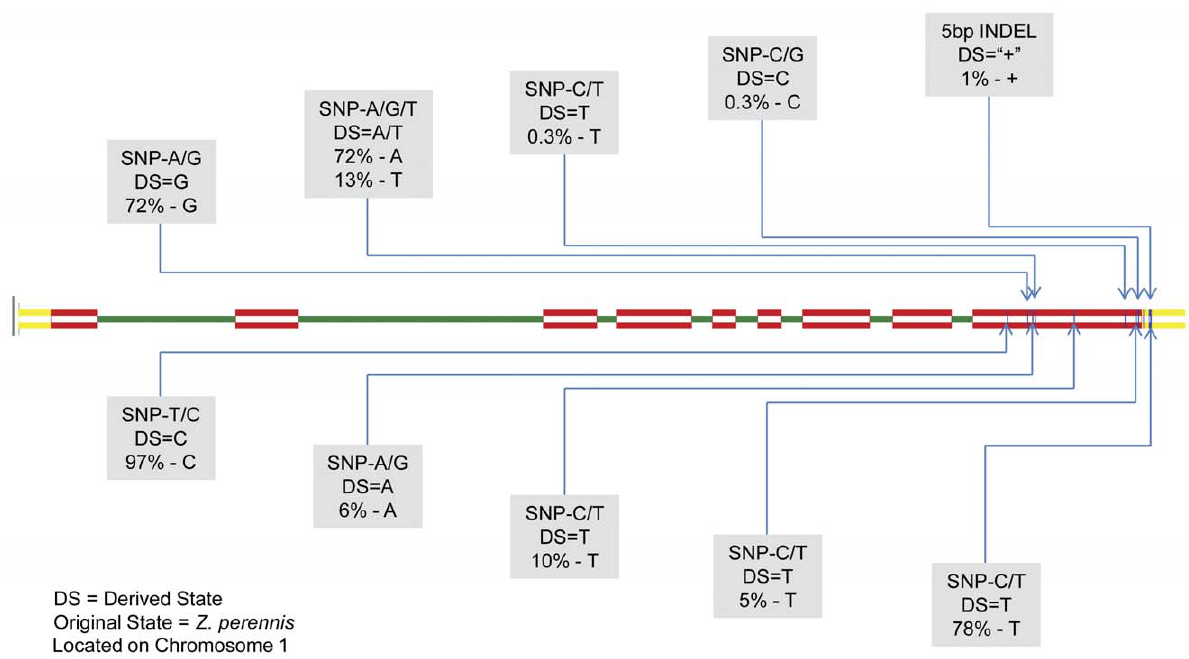
Figure 1. Sequence architecture of ZmLOX4 . Similar to the ZmLOX5 gene ZmLOX4 consists of 9 exons (shown in red), and 8 introns (shown in green). The major difference between the architecture of the two genes is the length of the second intron, much larger in ZmLOX4 spanning 11,191 bp (not shown). ZmLOX4 is located on the forward strand of chromosome 1:264,209,651–264,226,078, spanning 16,427 bp (B73 RefGen_v2). Vertical blue lines in the final 3 9 exon of the gene are the relative locations of SNPs discovered from Sanger sequencing. Their base pair change, derived state (as compared to Z. perennis ), and derived state percentages are shown in the grey boxes.